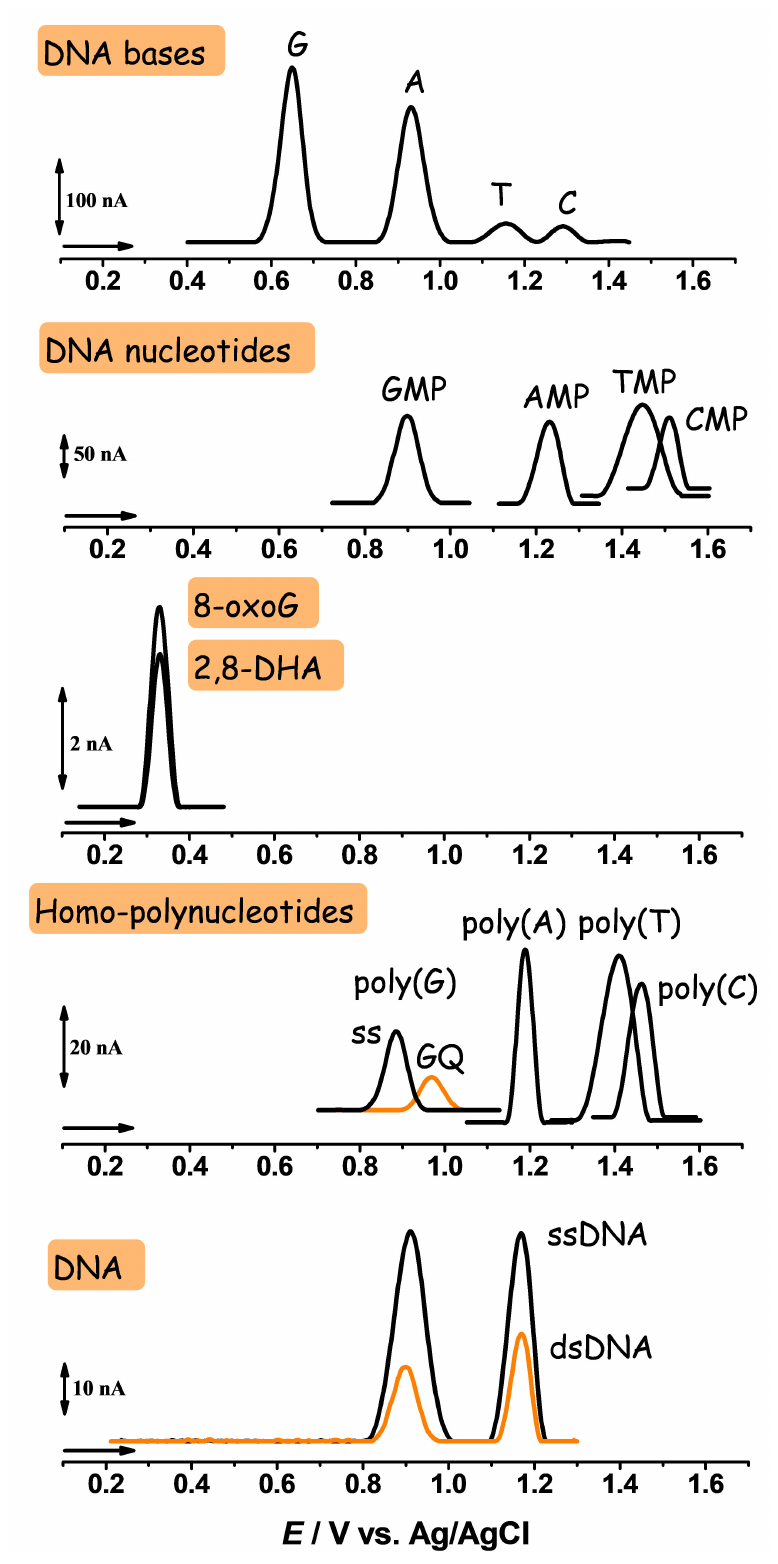
Figure 1. Baseline-corrected differential pulse voltammetry (DPV) with a glassy carbon electrode (GCE), in pH 7.0 solutions of: 20 µ M equimolar mixture of G, A, T, and C, 20 µ M GMP, 20 µ M AMP, 500 µ M TMP, 500 µ M CMP, 0.5 µ M 8-oxoG, 0.5 µ M 2,8-DHA, 5 µ g mL − 1 poly(G), 40 µ g mL − 1 poly(A), 100 µ g mL − 1 poly(T), 100 µ g mL − 1 poly(C), 60 µ g mL − 1 dsDNA, and 60 µ g mL − 1 ssDNA. Adapted from [11,18,32–35] with